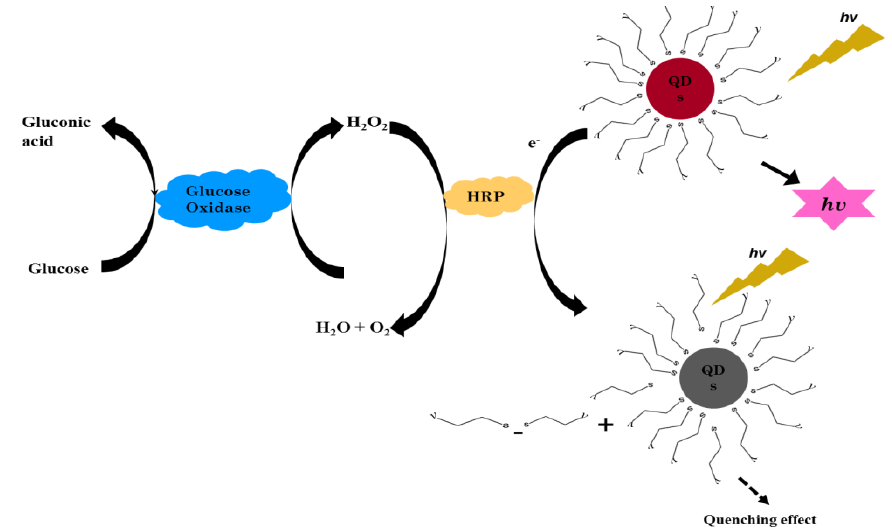
Figure 1. Schematic representation of successive reactions involved in the sensitive detection of glucose by means of GO X :HRP/CdSe/ZnS-TGA QD system.